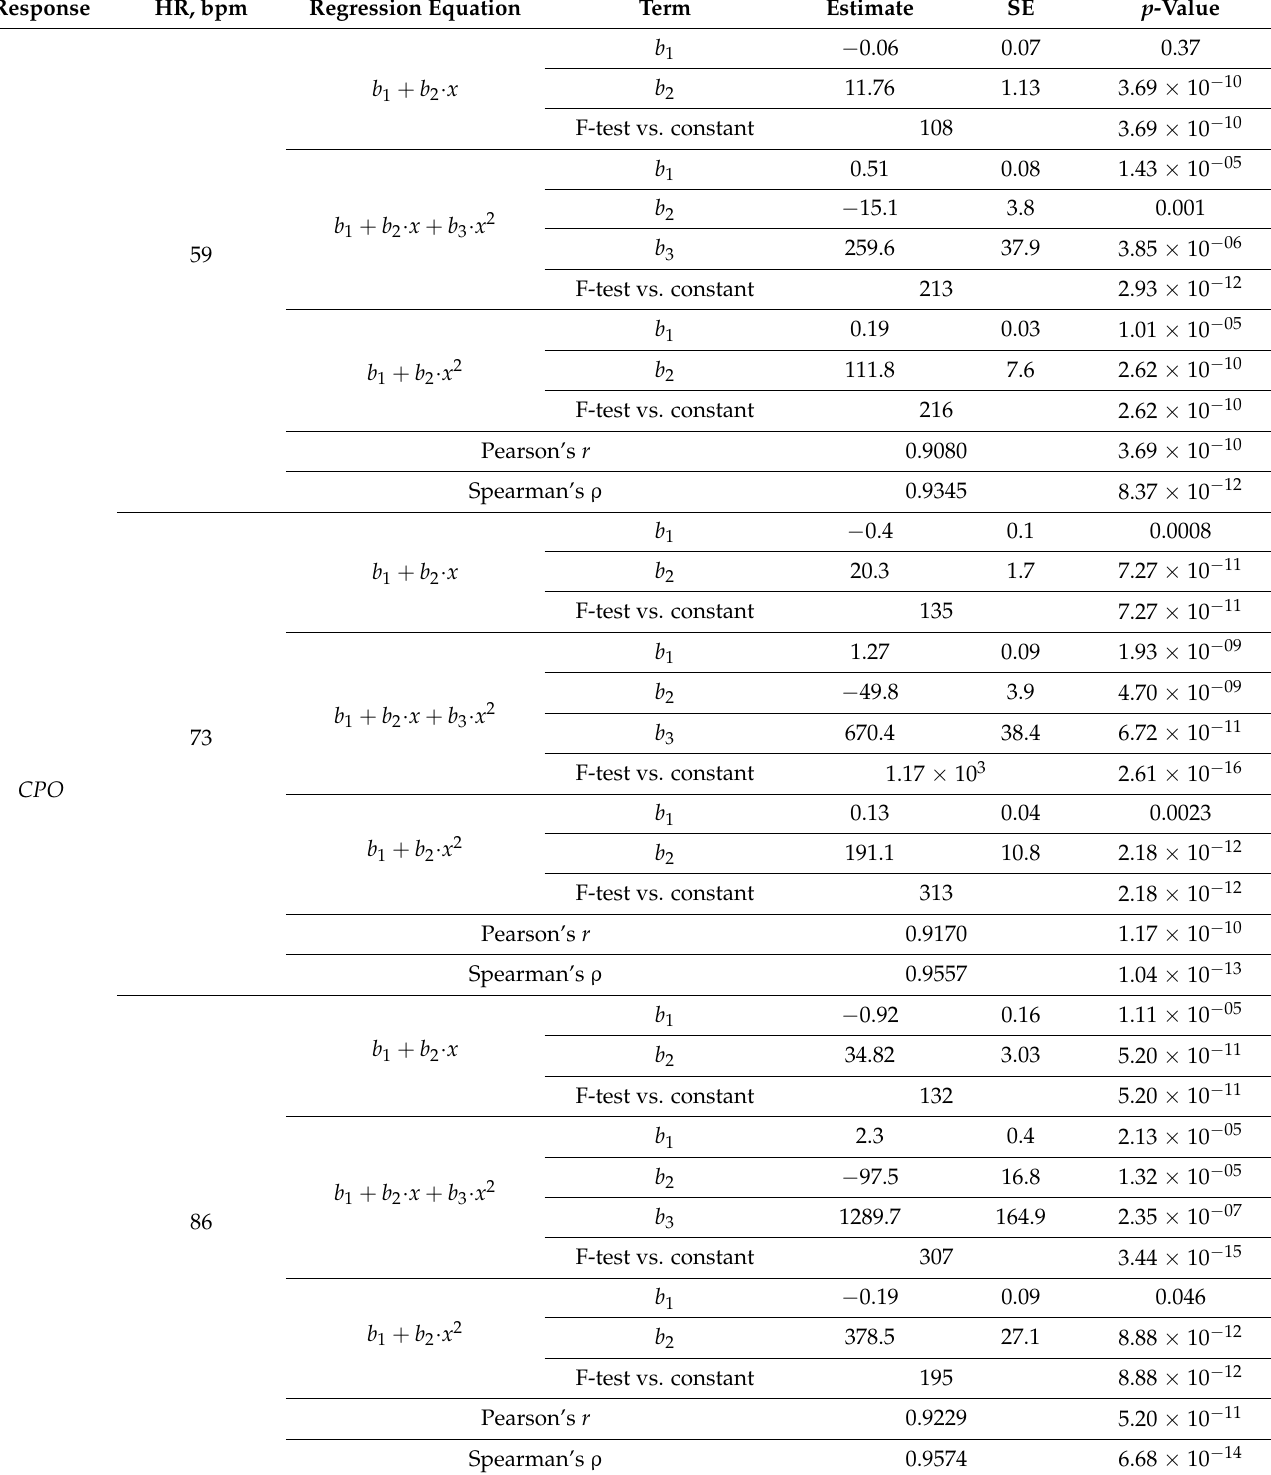
Table 2. Data of statistical analysis of different regression models for CPO